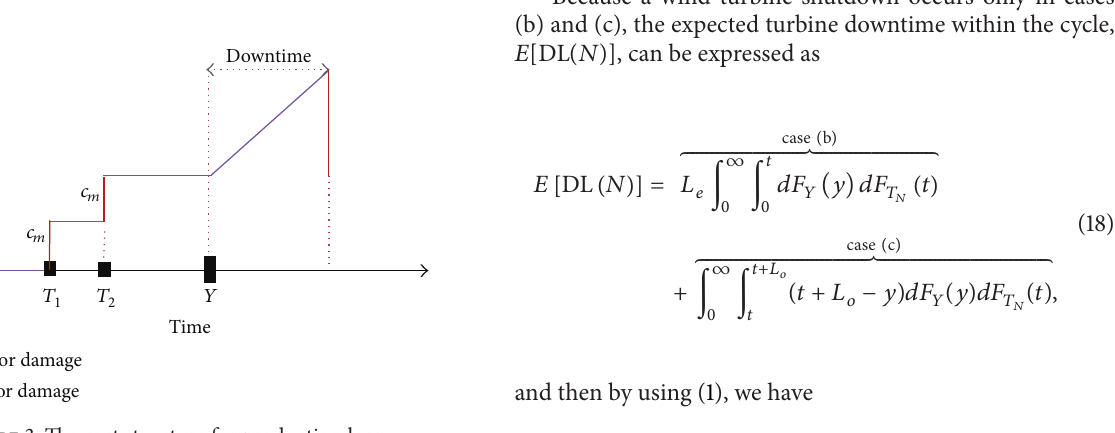
Figure 3: The cost structure for production